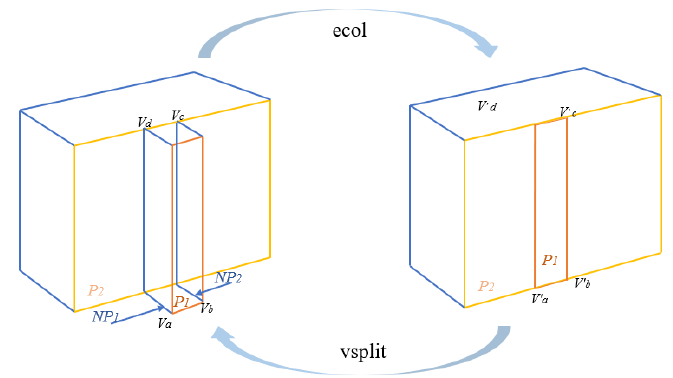
Figure 4. Detail plane simplification based on the facet shift